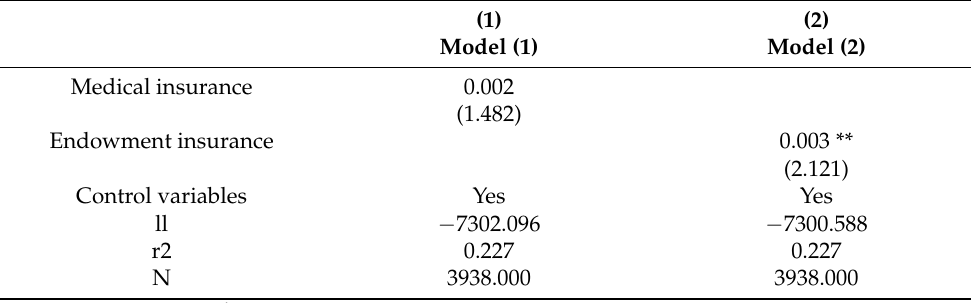
Table 3. The estimates of heterogeneous